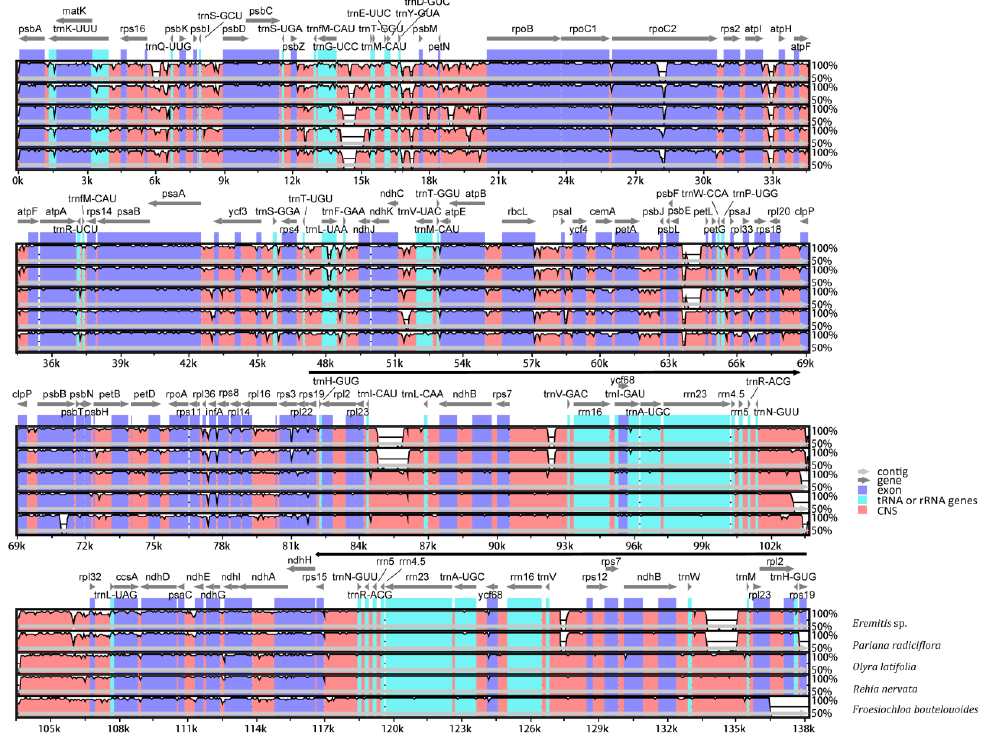
Figure 3. Whole chloroplast genome alignments for Olyreae. Buergersiochloa bambusoides was used as a reference and presented as the uppermost line in the VISTA ‐ based identity plots. Thick arrowed black lines show the inverted repeat regions (IRs) in the chloroplast genome. All the chloroplast genome regions are color coded as protein coding, rRNA, tRNA or conserved non ‐ coding sequences (CNS).